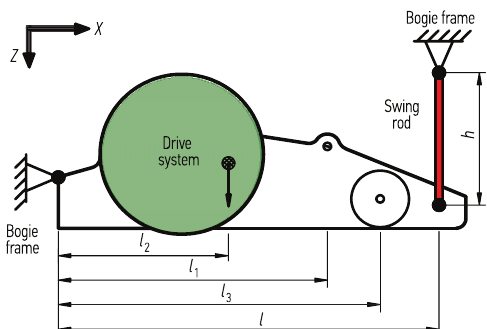
Fig. 17. The flexible suspension drive system